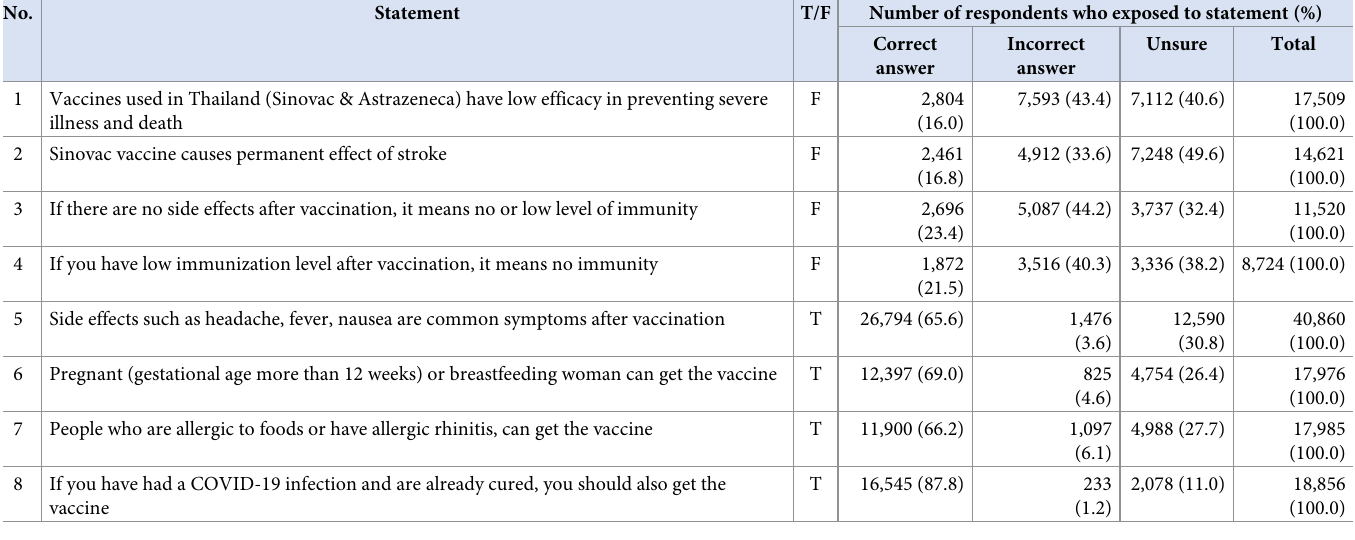
Table 2. The number and proportion of respondents who were exposed to and provided correct and incorrect answers to eight selected true and false statements. No. Statement T/F Number of respondents who exposed to statement